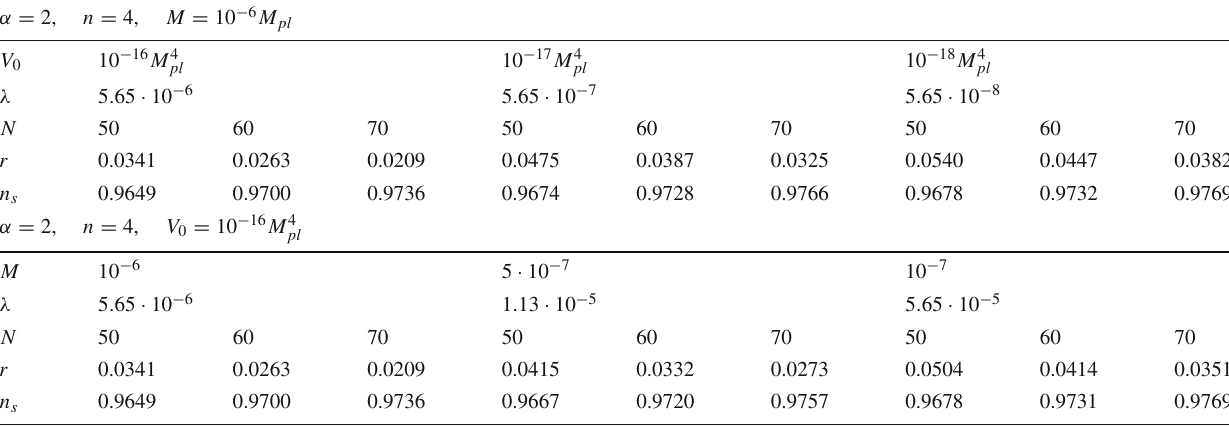
Table 2 Predictions for the scalar spectral index n s and the tensor-to- scalar ratio r for the scenario of non-canonical inflation with deformed- steepness potential, for fixed α = 2, n = 4, for e-folding number N being 50, 60 and 70, and with fixed M and varying V 0 (upper sub-